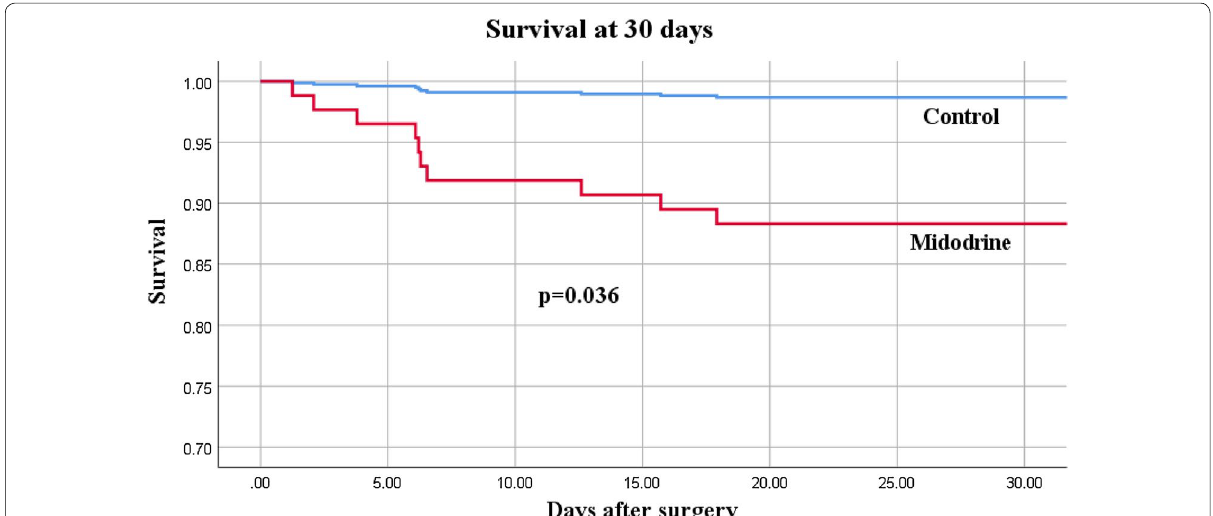
Fig. 1 Survival at 30 days after cardiac surgery with Cox proportional hazard model after controlling for Euroscore II, CPB duration and propensity score. Adjusted Hazard Ratio for mortality with midodrine: 12.5 (1.5–105.2), p